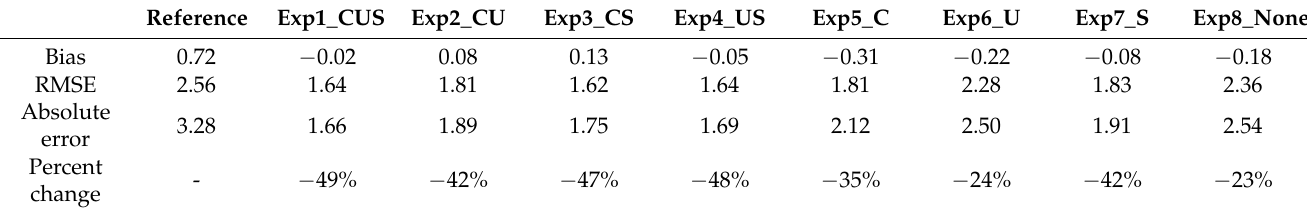
Table 3. The mean bias and RMSE of each sensitivity experiment with EMTnet model. “Reference” refers to the result of the L86 model. In the nomenclature of Exp1 to Exp7, postfixes C, U, and S denote parameters CLW, U , and SST considered in the corresponding experiment, respectively. In Exp8, the postfix “none” means no additional information is considered. The percent change means the ratio of changes in absolute error compared to the reference value. The units of mean bias, RMSE, and absolute error are